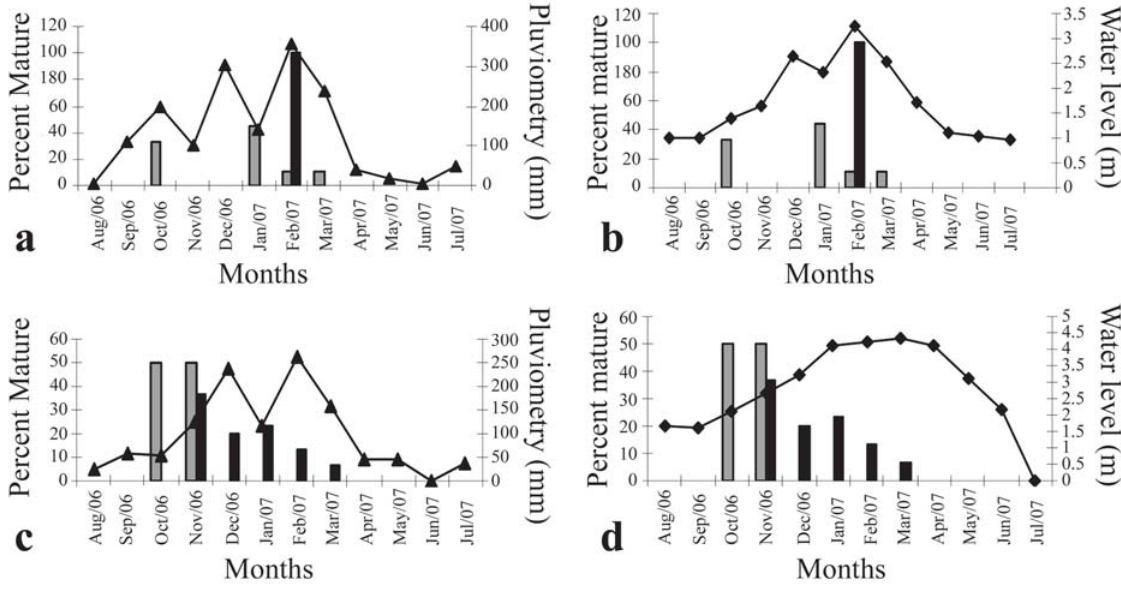
Fig. 5. Relative frequency of the stage of gonadal maturation (MA) by collection period for P . mesopotamicus females ( ) and males ( ) with the monthly variations in rainfall ( ) and water level ( ) in the headwaters (a, b) and the flood area (c, d), respectively, between August 2006 and July 2007.